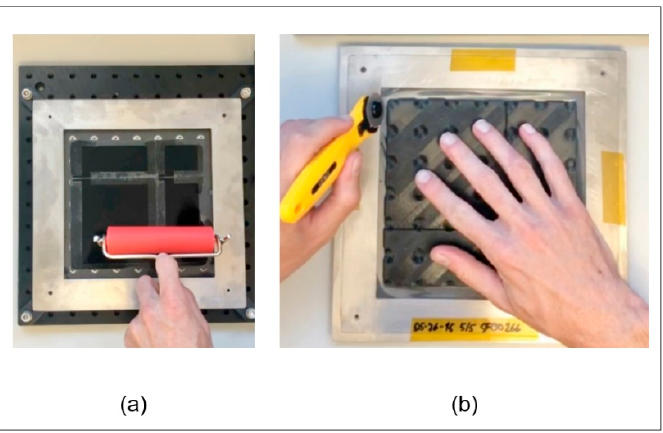
Figure 4. Detail of the transfer process ( a ) and the cutting process ( b ).